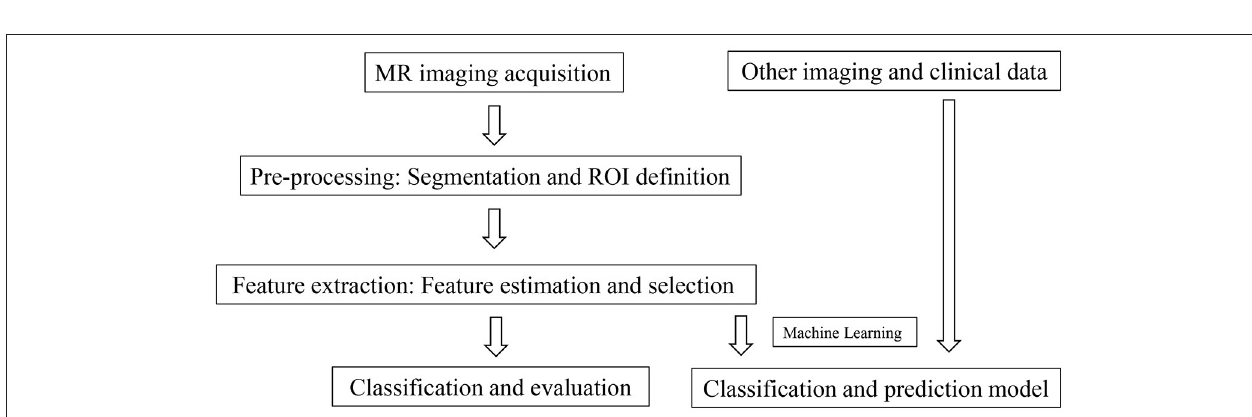
FIGURE 3 | Overview of the MRTA simplified workflow. MRTA, magnetic resonance texture analysis.